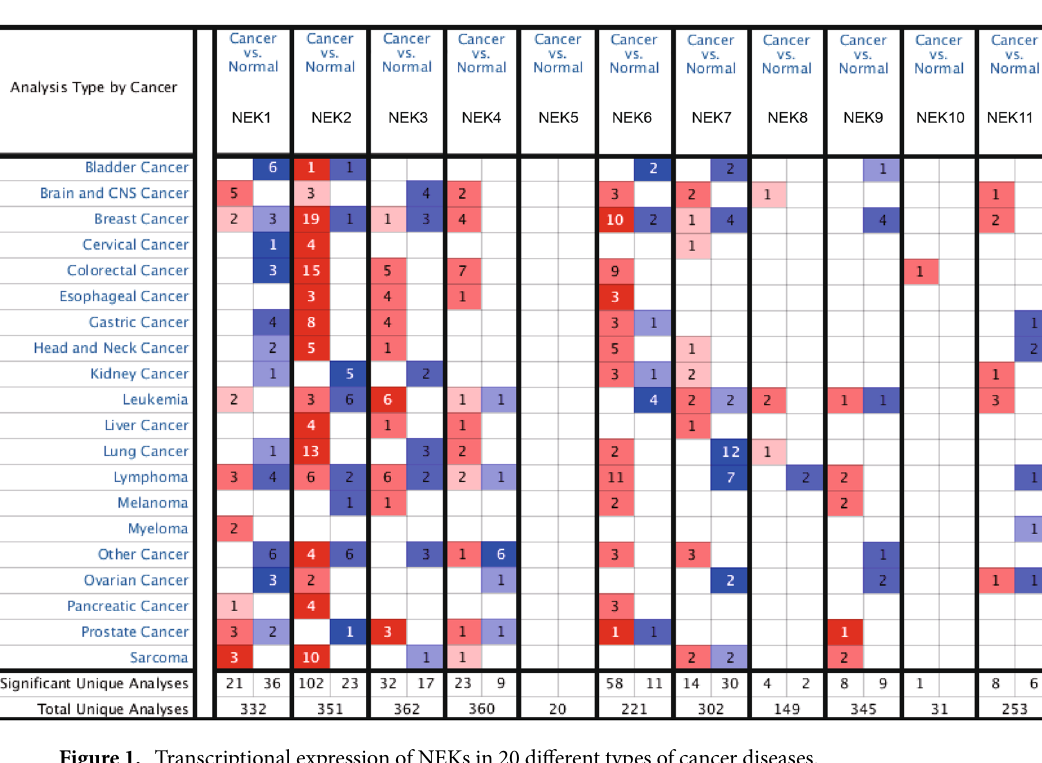
Figure 1. Transcriptional expression of NEKs in 20 different types of cancer diseases.